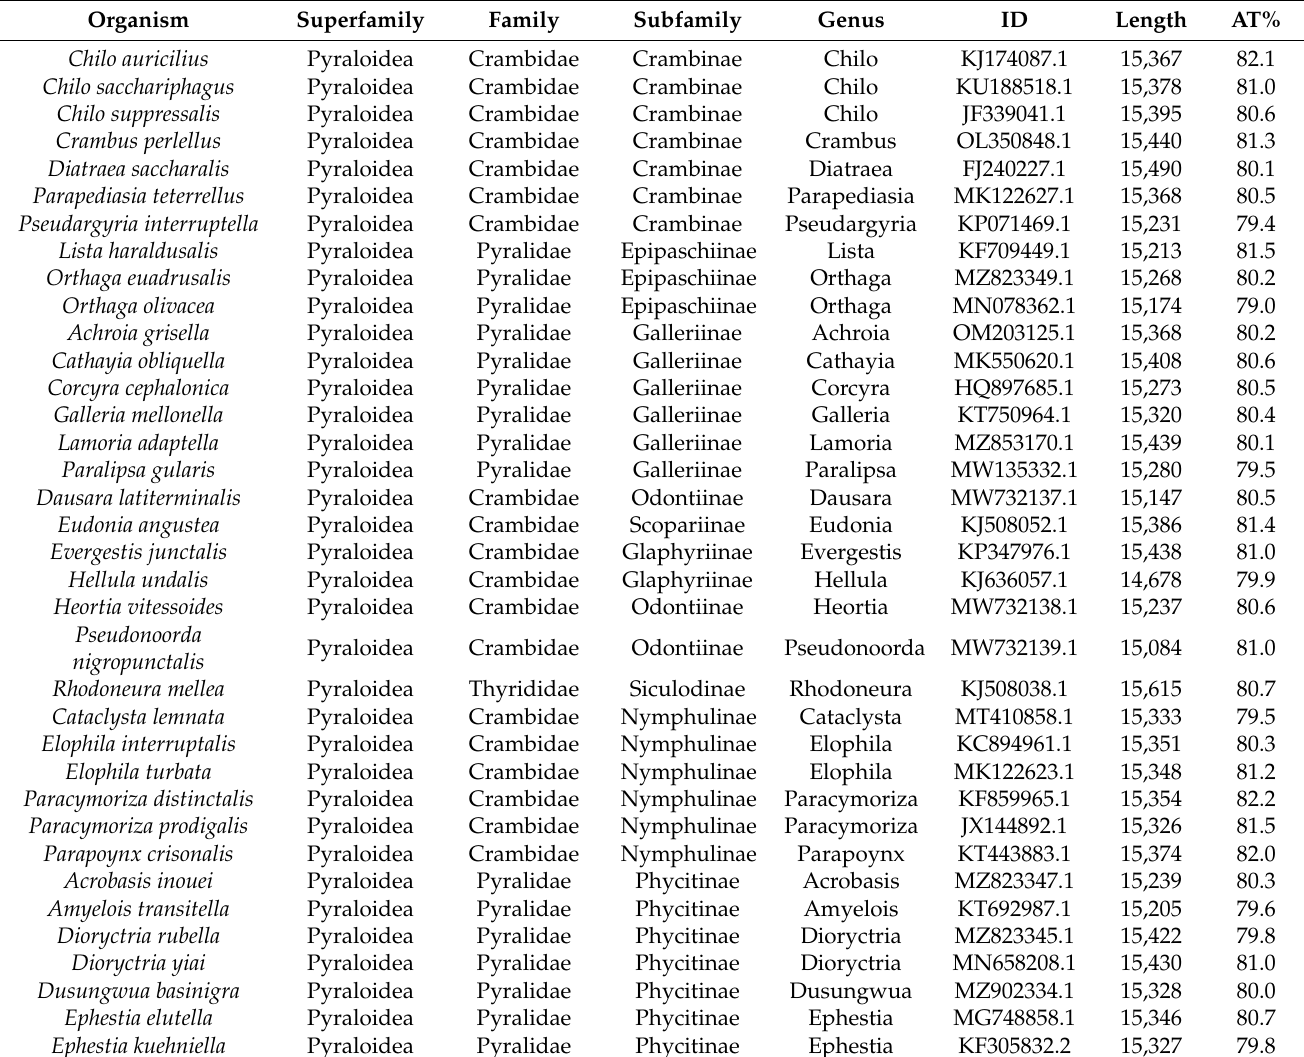
Table 1. Pyraloidea species used in the phylogenetic